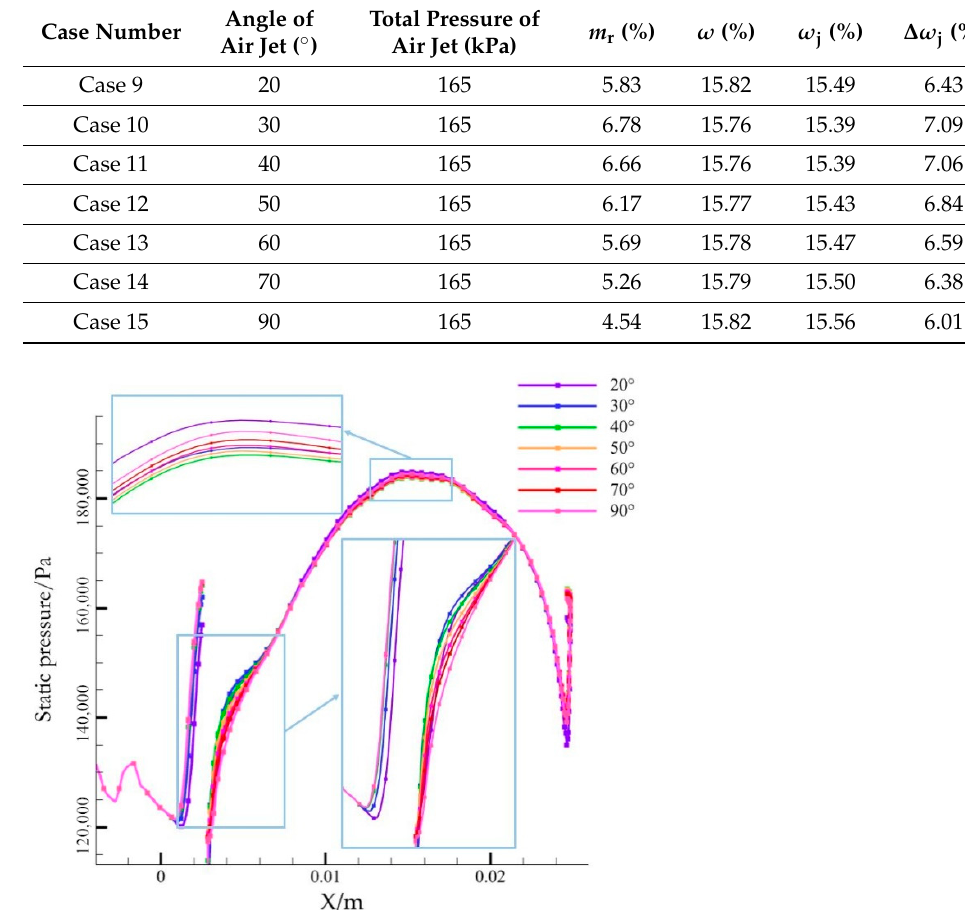
Table 4. Related parameters of various angles of air jet.